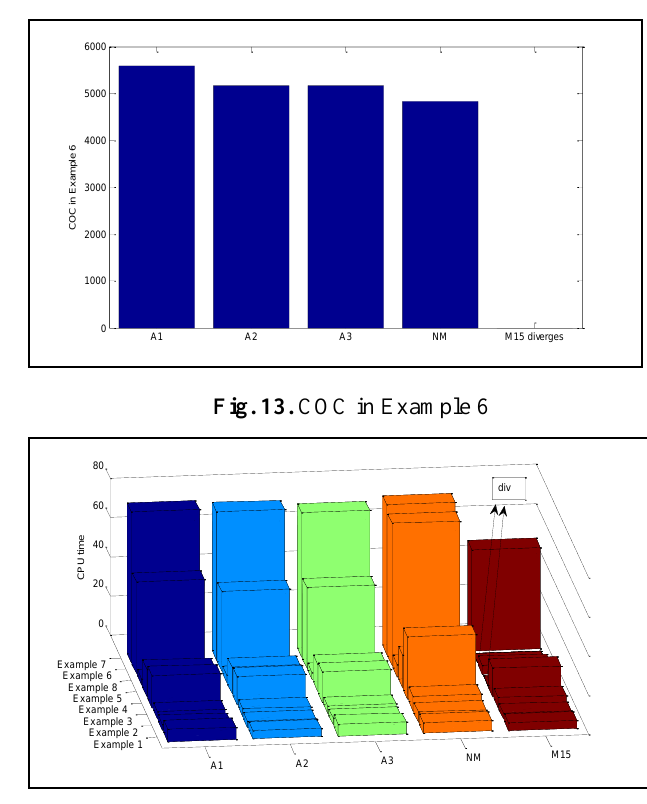
Fig. 10. Error drops for Example 7